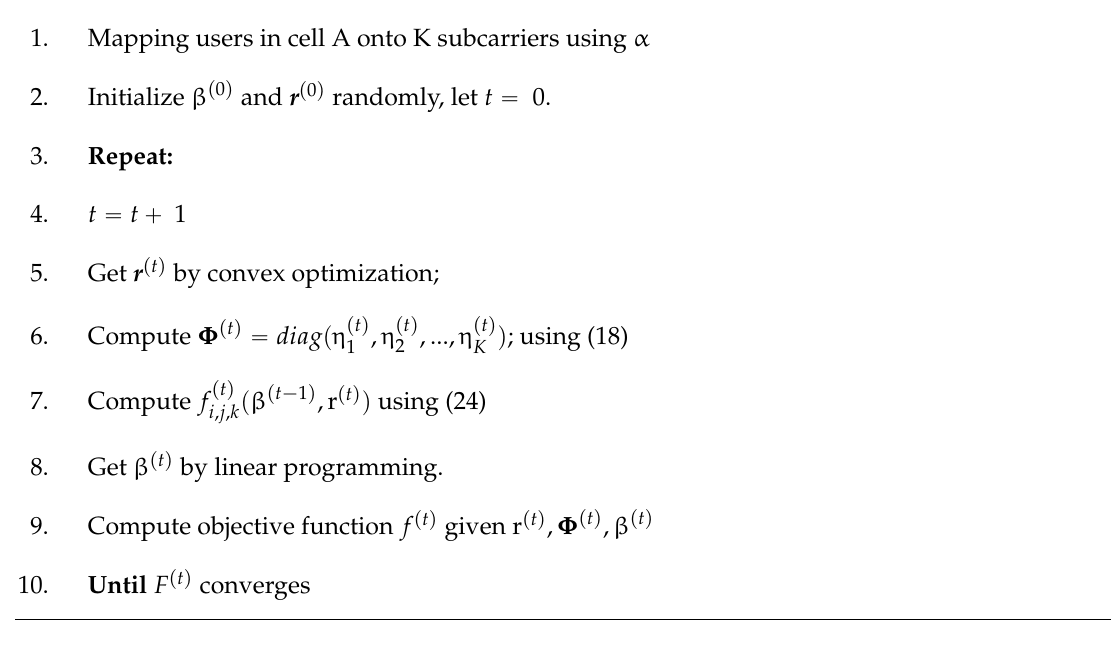
Algorithm 1: The Proposed Novel Resource Allocation